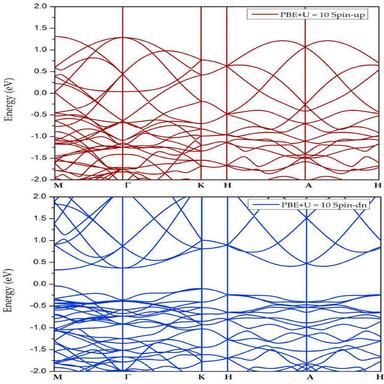
Calculated band structures of rhombohedral R3c-type HoNiO3 in both spin channels with DFT þ U method (U ¼ 10 eV).